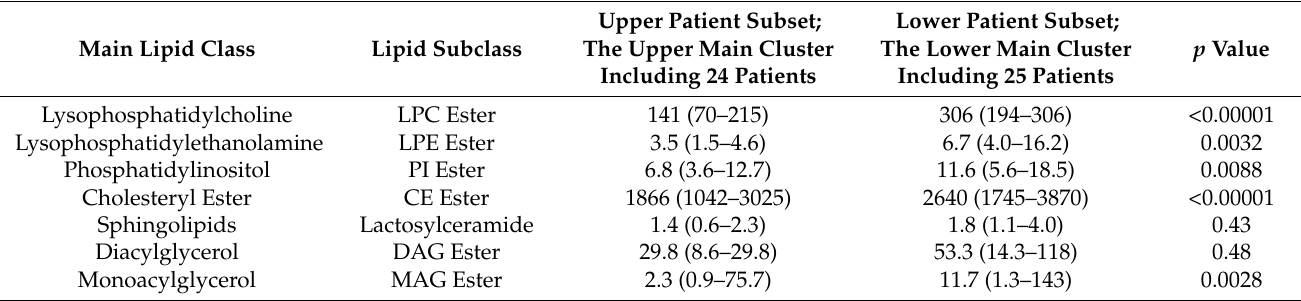
Table 5. A comparison of the two contrasting patient subsets identified in the hierarchical cluster analysis of total lipid levels (from Figure 1), and a comparison of the upper main subcluster (the 24 patients with generally low levels of lipids indicated by purple color at the top right part of Figure 1) and the lower subcluster (the 25 patients with generally high levels of lipids indicated by brown color at the right, lower part of Figure 1). We compared the total levels of the seven lipid classes/subclasses included in the clustering analysis. All concentrations are given in µ M, and the Mann–Whitney U test was used for the statistical comparisons of these two contrasting patient subsets; the corresponding p values are shown in the far right